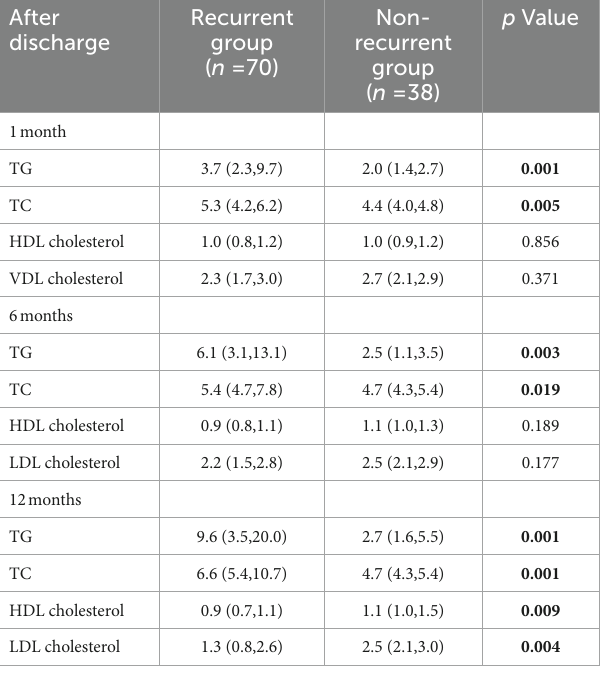
TABLE 2 Serum lipid levels and lipid-lowering treatments of patients with HTGP during index hospitalization.